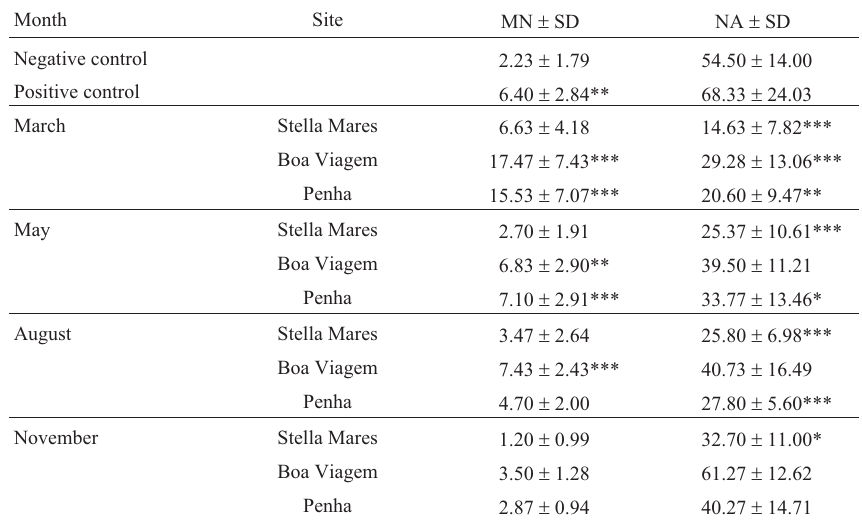
Table 1 - Average frequency of micronucleus and nuclear abnormalities in B. soporator for 1000/cells during four months in 2005 at three sites in Salva- dor, Bahia, Brazil.